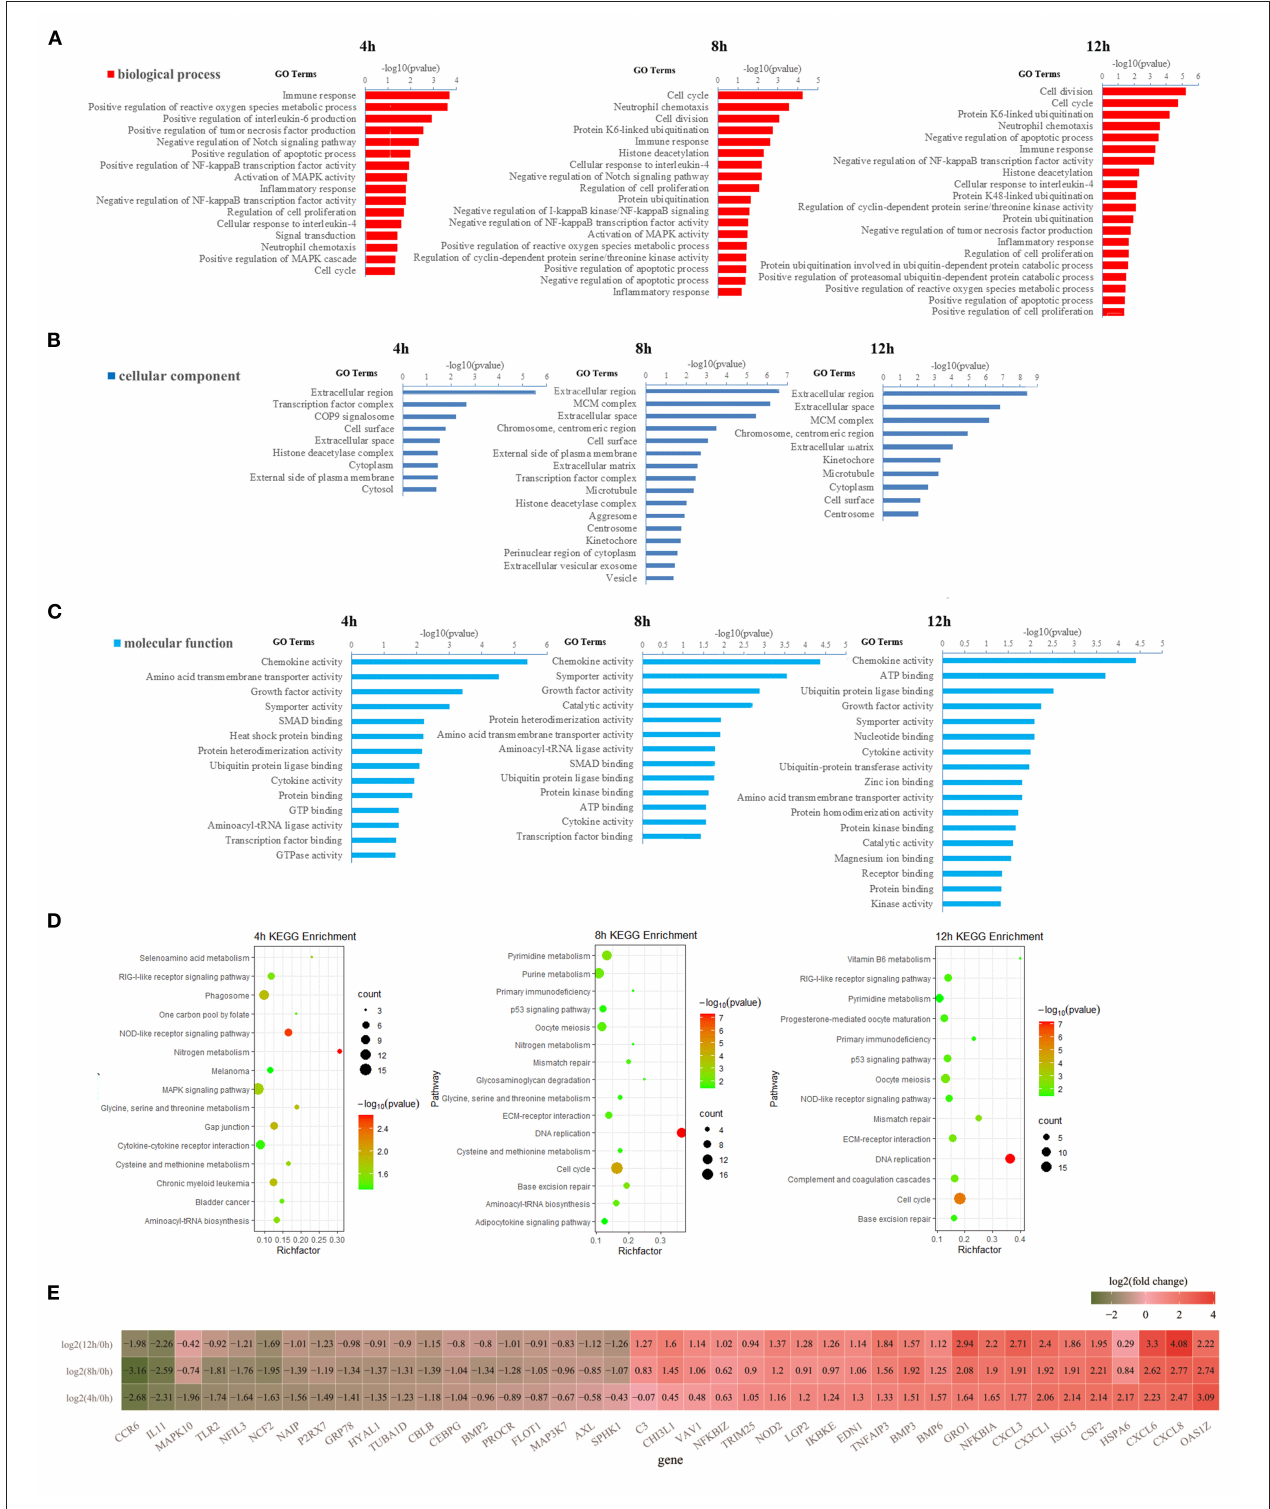
FIGURE 2 | Gene ontology (GO) and Kyoto Encyclopedia of Genes and Genomes (KEGG) enrichment analysis of DEGs. (A) The significantly enriched GO terms in the biological process at 4, 8, and 12h, respectively. (B) The significantly enriched GO terms in cellular components at 4, 8, and 12h, respectively. (C) The significantly enriched GO terms in molecular function at 4, 8, and 12h, respectively. (D) The significantly enriched KEGG pathway at 4, 8, and 12h, respectively. (E) The heatmap of differentially expressed genes (DEGs) involved in immune response, inflammatory response, chemokine activity, cytokine activity, NOD-like receptor (NLR) signaling pathway, phagosome, RIG-I-like receptor signaling pathway, and COP9 signalosome. In (E) , the dark green represents down-regulationand the red represents upregulation. Frontiers in Veterinary Science |